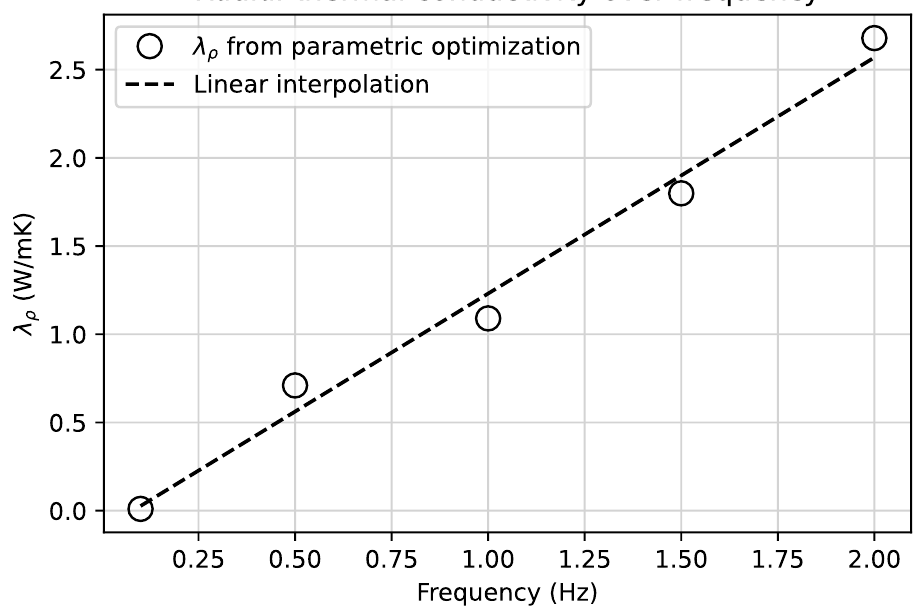
Figure 5. Resulting λ ρ from the optimization over the frequency f . Shown also is a linear trend line.